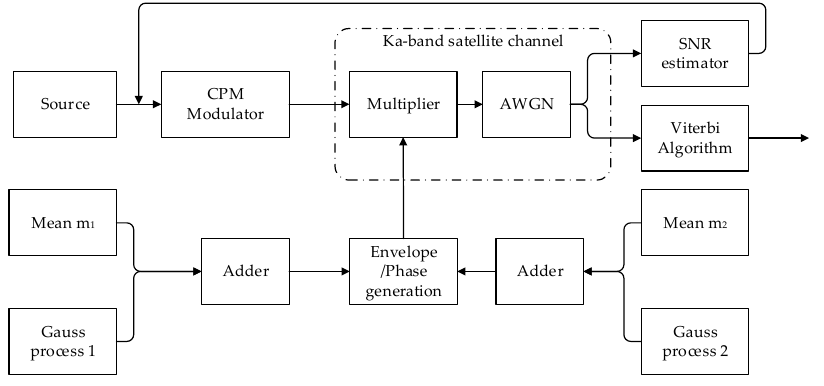
Figure 2. Schematic of the system.